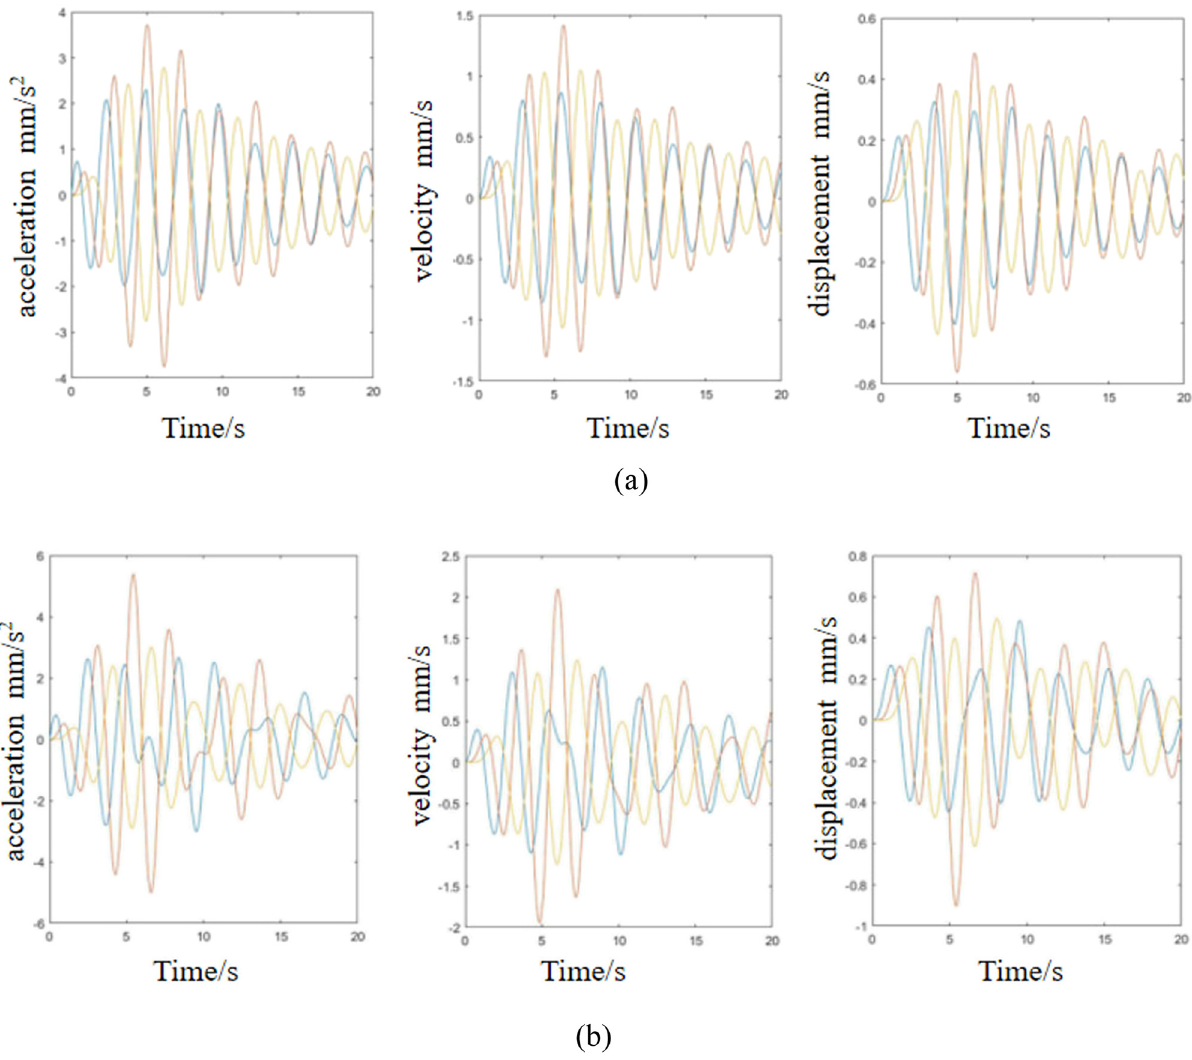
Figure 4: Velocity, displacement, and acceleration of top load with di ff erent reduction factors: ( a ) sti ff ness reduction factor is 1 and ( b ) sti ff ness reduction factor is